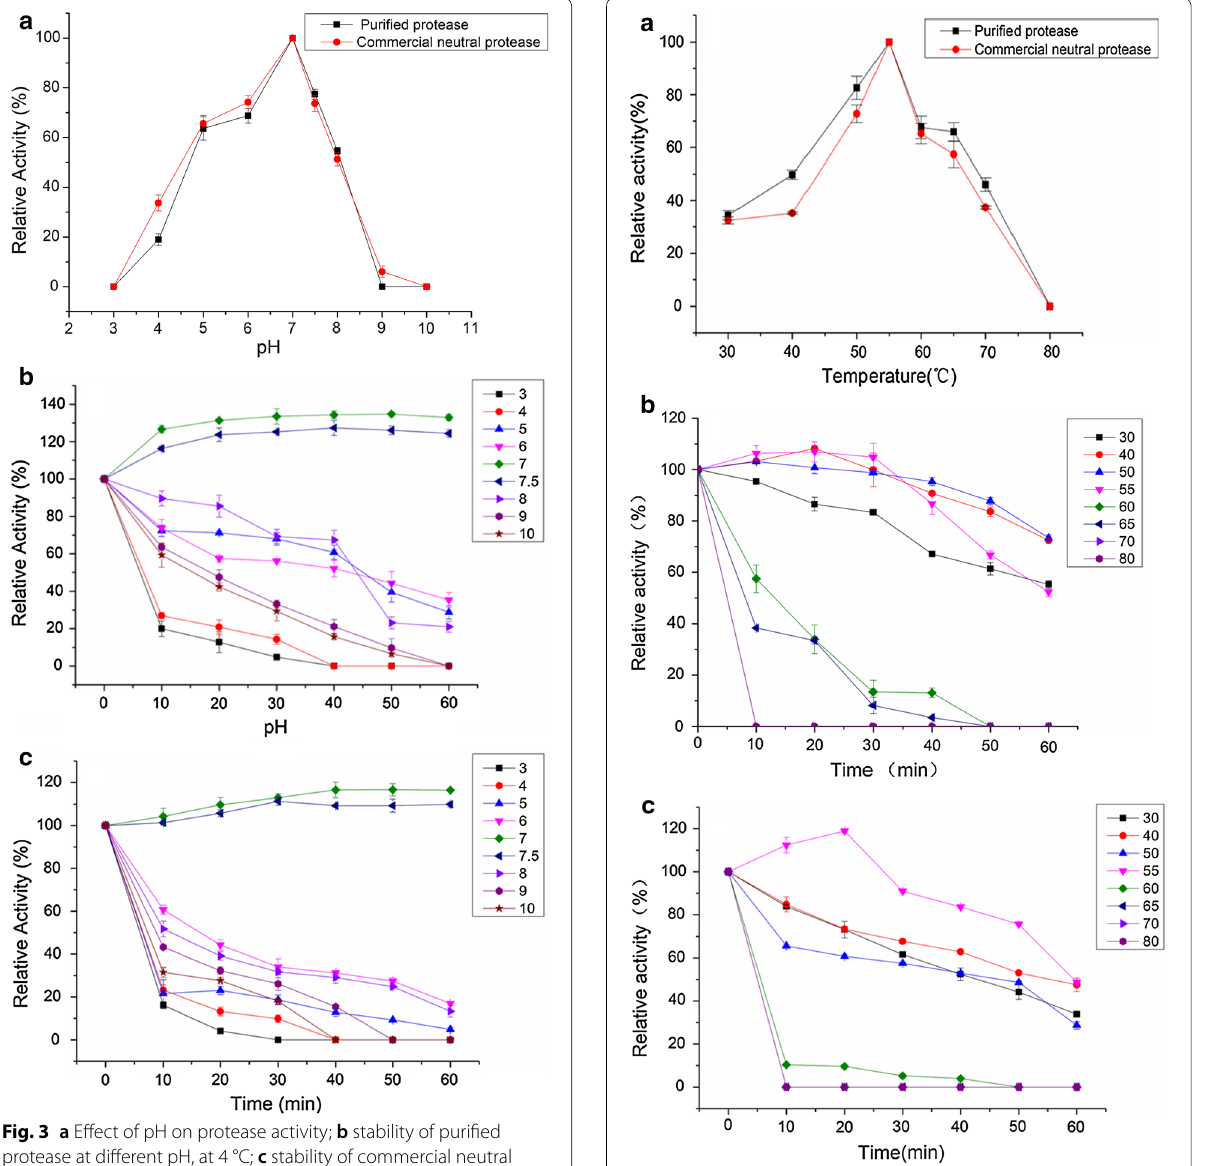
temperature on purified protease activity was determined at different incubation times (0–60 min) at different temperatures at pH 7.0. The residual protease activity was estimated under the enzyme assay conditions and indicated as the percentage relative to the activity of the untreated protease activity; c stability of temperature on commercial neutral protease activity was determined at different incubation times (0–60 min) at different temperatures at pH 7.0. The residual protease activity was estimated under the enzyme assay conditions and indicated as the percentage relative to the activity of the untreated protease